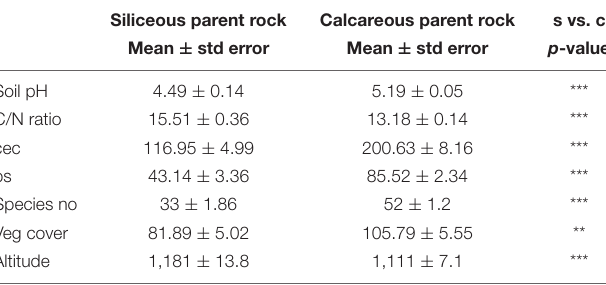
TABLE 1 | Mean and standard error of the mean (std error) of various environmental parameters from Arnica montana grasslands in the Apuseni Mountains (Romania), distinguished between two geologies (s = siliceous, c = calcareous).